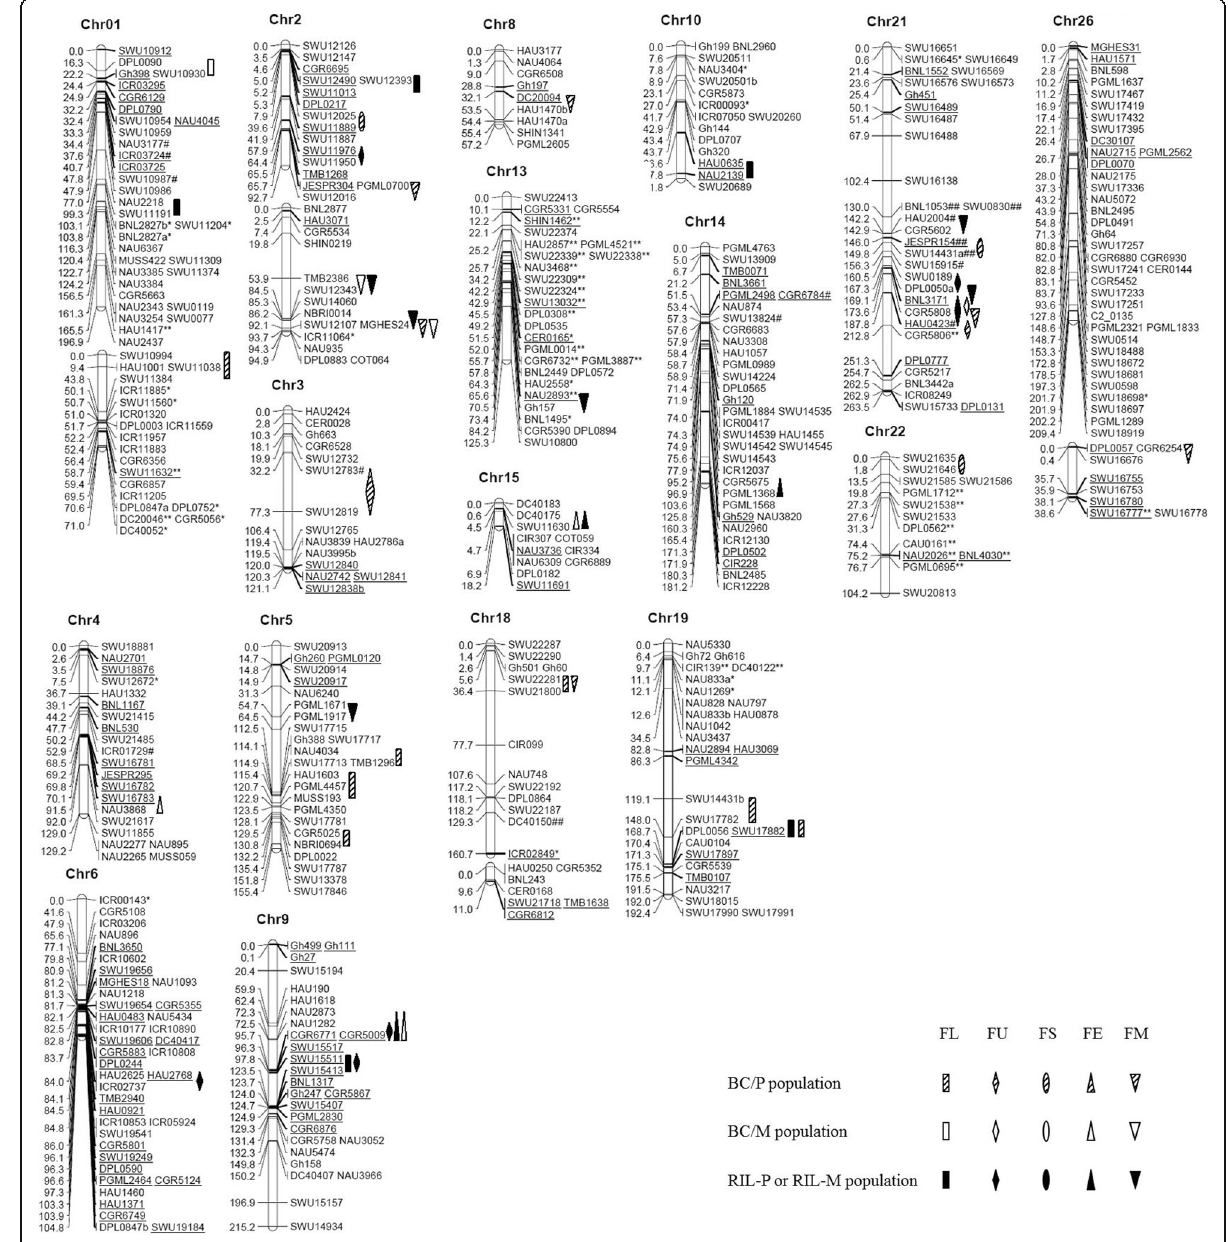
Fig. 1 Locations of QTLs controlling fiber quality traits in BC/P and BC/M trials * and ** (# and ##), marker showed respectively segregation distortion significant at P = 0.05 and 0.01 levels; markers with * and ** skewed toward the GX1135 alleles, and markers with # and ## skewed toward the GX100 – 2